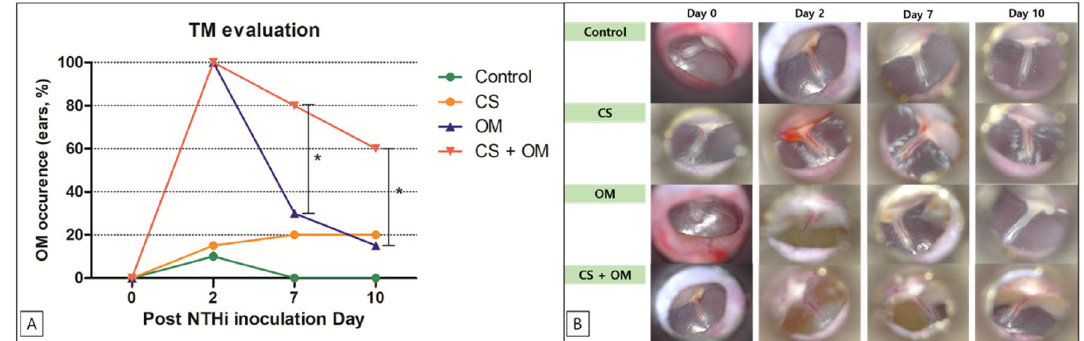
Figure 1. Induction of otitis media (OM). ( A ) The otitis media + cigarette smoke (CS + OM) group shows higher induction of OM than does the OM group on days 7 (P = 0.011) and 10 (P = 0.006) after inoculation. ( B ) Otomicroscopic examination findings of the tympanic membrane.